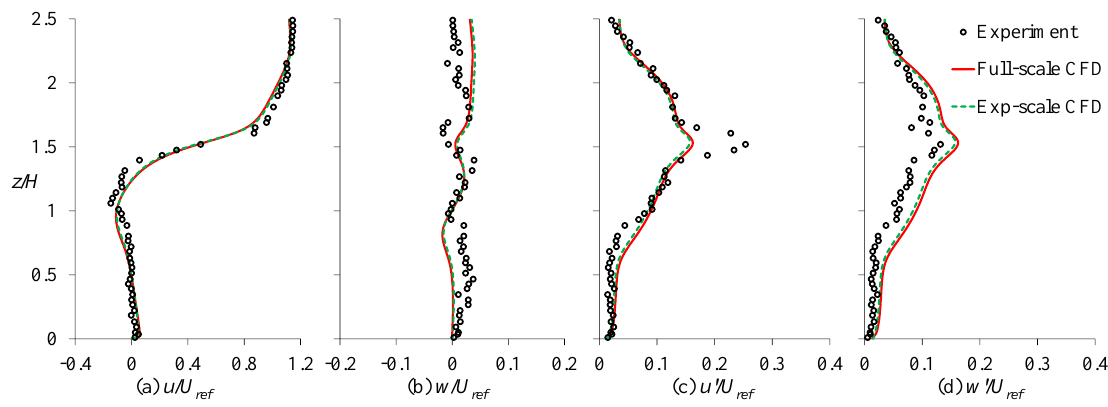
Figure 14. Normalized middle-line velocity profiles at canyon 5 comparing experimental and CFD results for the case with a reversed wind catcher. ( a ) Mean stream-wise velocity, ( b ) mean vertical velocity, ( c ) stream-wise velocity fluctuation, and ( d ) vertical velocity fluctuation. “Exp-scale” and “Full-scale” are experimental scale and real scale in a built